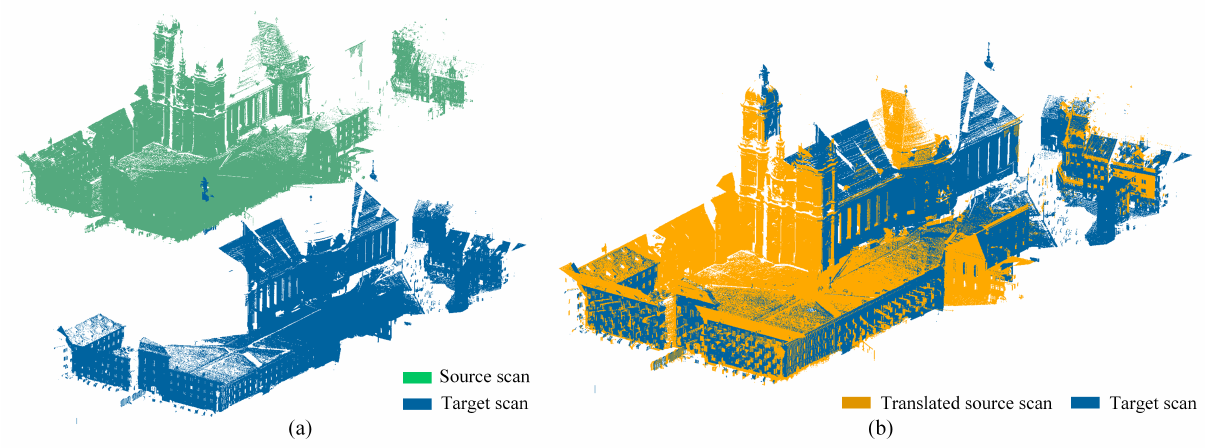
Figure 4. Data and results of StGallen dataset. (a) Source and target point clouds. (b) Matching